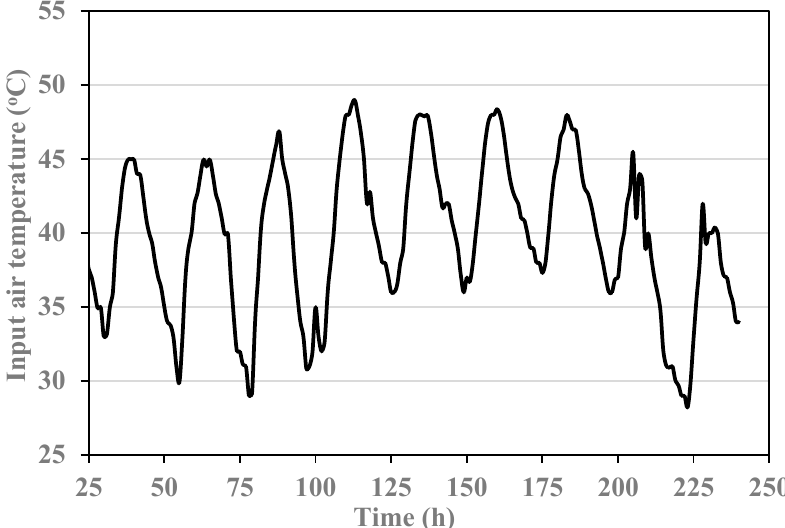
Figure 4. The ten-days input air temperature variations were used to test the various thermal bridges under hot climate conditions.